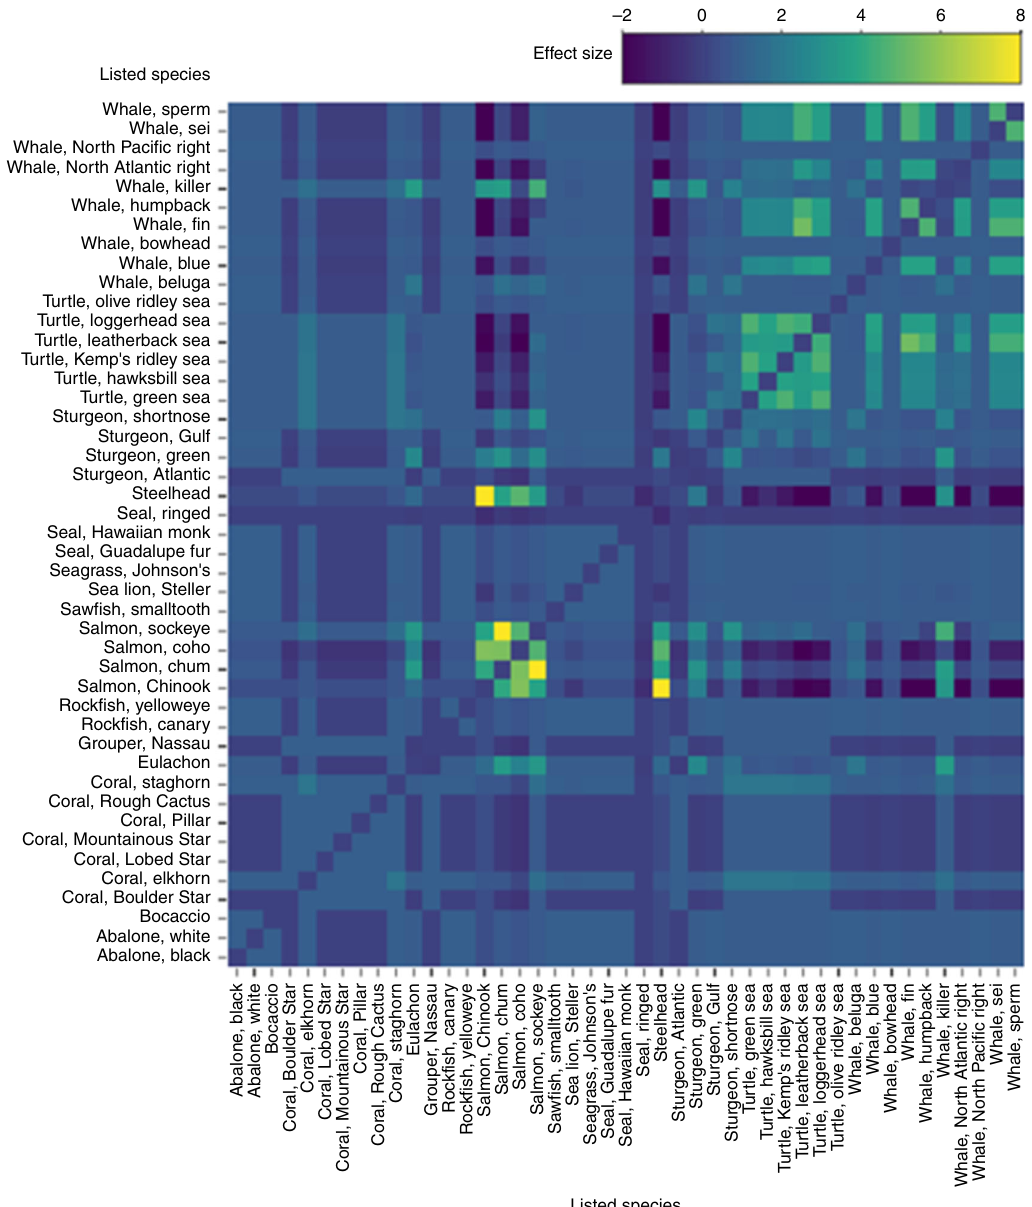
Fig. 4 Heatmap displaying differences between the observed and expected frequency with which jeopardy determinations were made for pairs of species during the same U.S. Endangered Species Act section 7 consultation between U.S federal agencies and the National Marine Fisheries Service from 2000 to 2017. Higher values indicate species pairs for which observed co-jeopardizations were greater than would be expected under a random